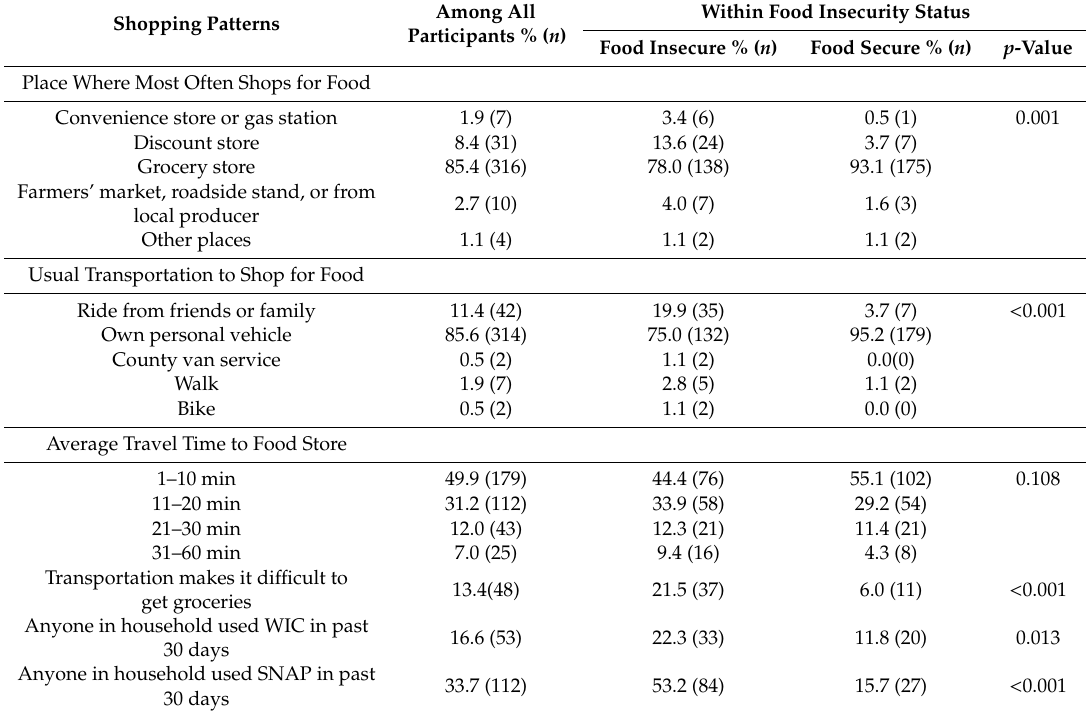
Table 2. Di ff erences in shopping patterns and use of nutrition-related resources by food insecurity status ( N = 370) *. WIC, Supplemental Nutrition Program for Women, Infants and Children; SNAP, Supplemental Nutrition Assistance